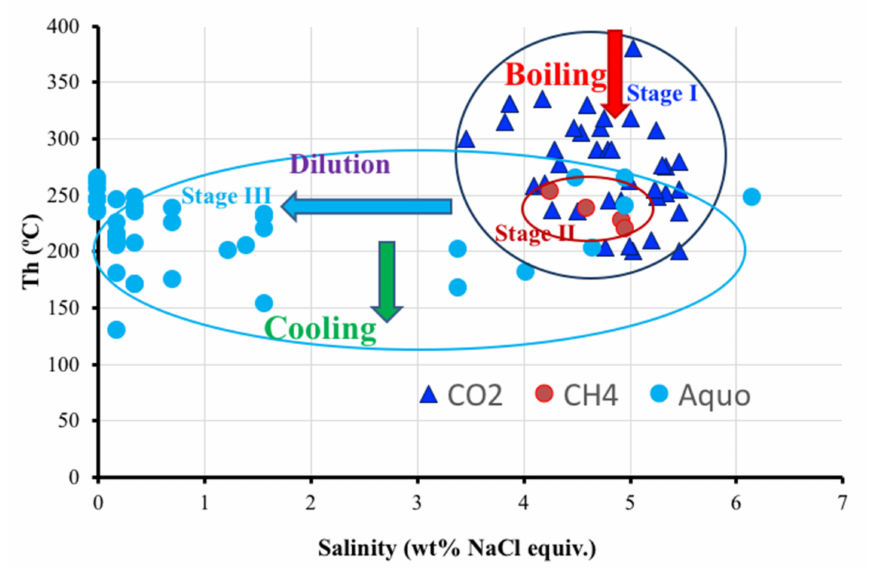
Figure 10. The diagram of salinity (wt.% NaCl eq.) vs. T h ( ◦ C) corresponding to fluids identified in